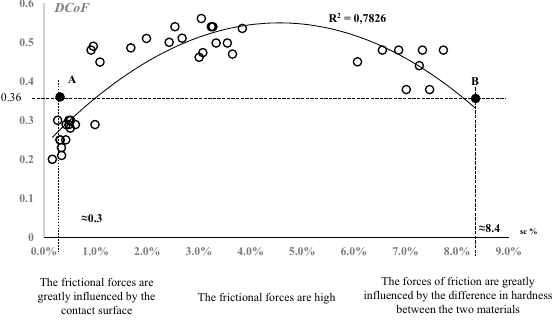
Fig. 6 Correlation between the sliding-contact factor and the dynamic coefficient of friction